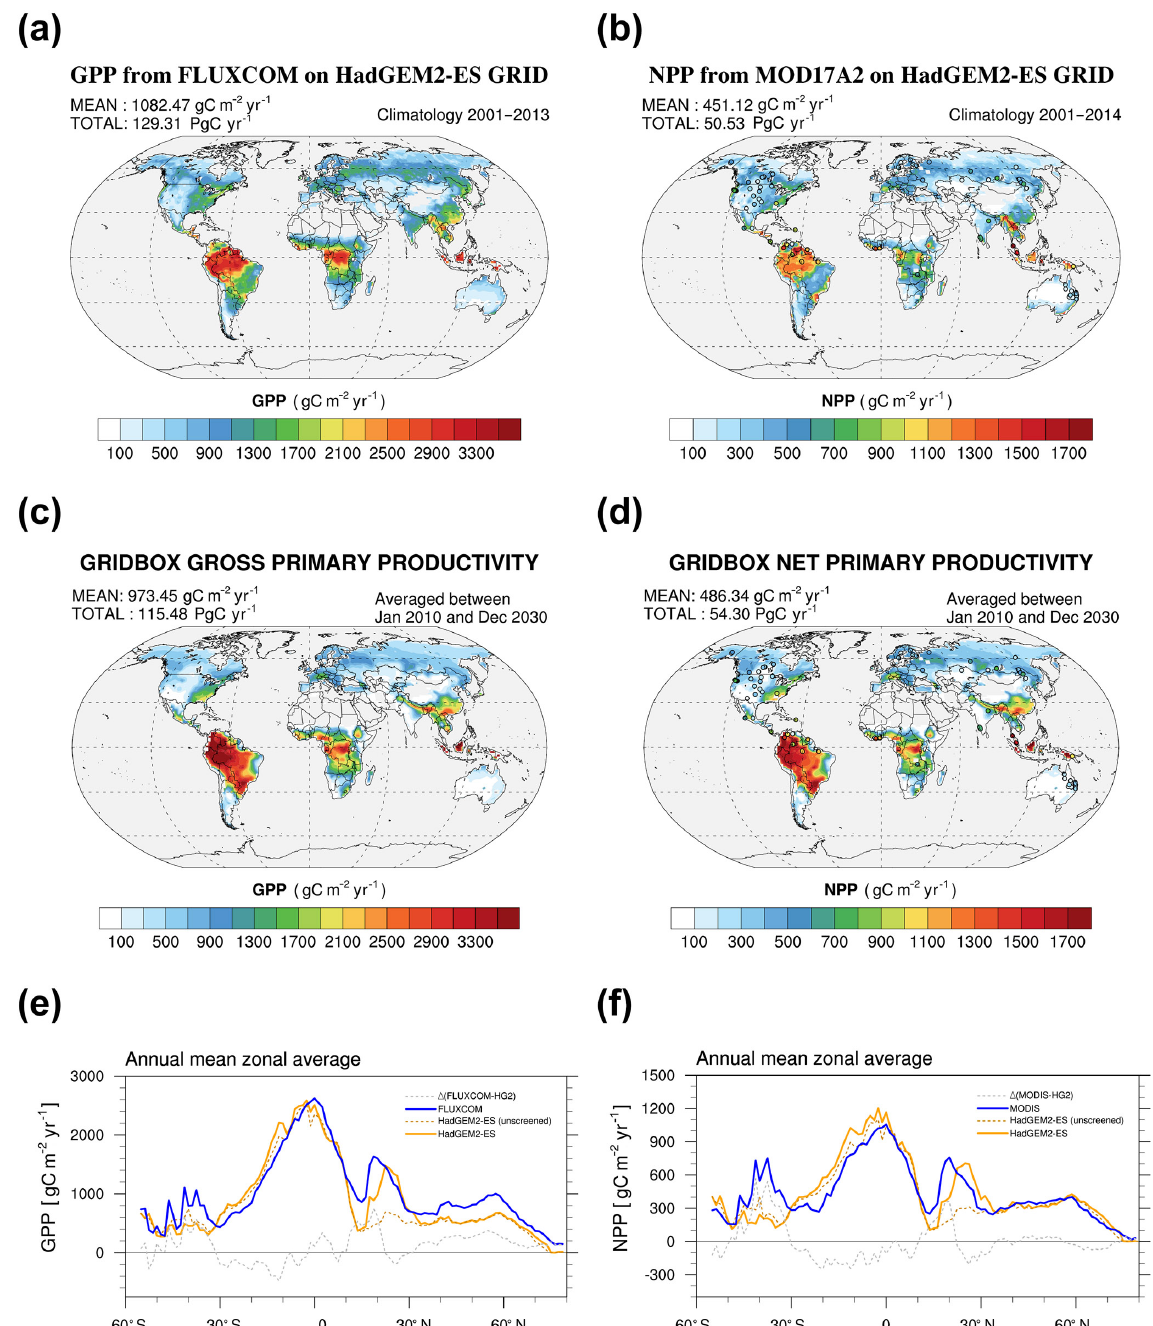
Figure 1. Global annual estimates of gross primary productivity (GPP, a, c, e ) and net primary productivity (NPP, b, d, f ). Observation- ally based estimates from FLUXCOM MTE analysis ( a ), MODIS MOD17A2 ( b ) and HadGEM2-ES ( c, d ). Zonal means are shown in panels (e) and (f) . The circles on the NPP maps ( b, d ) represent in situ estimates from the EMDI project.